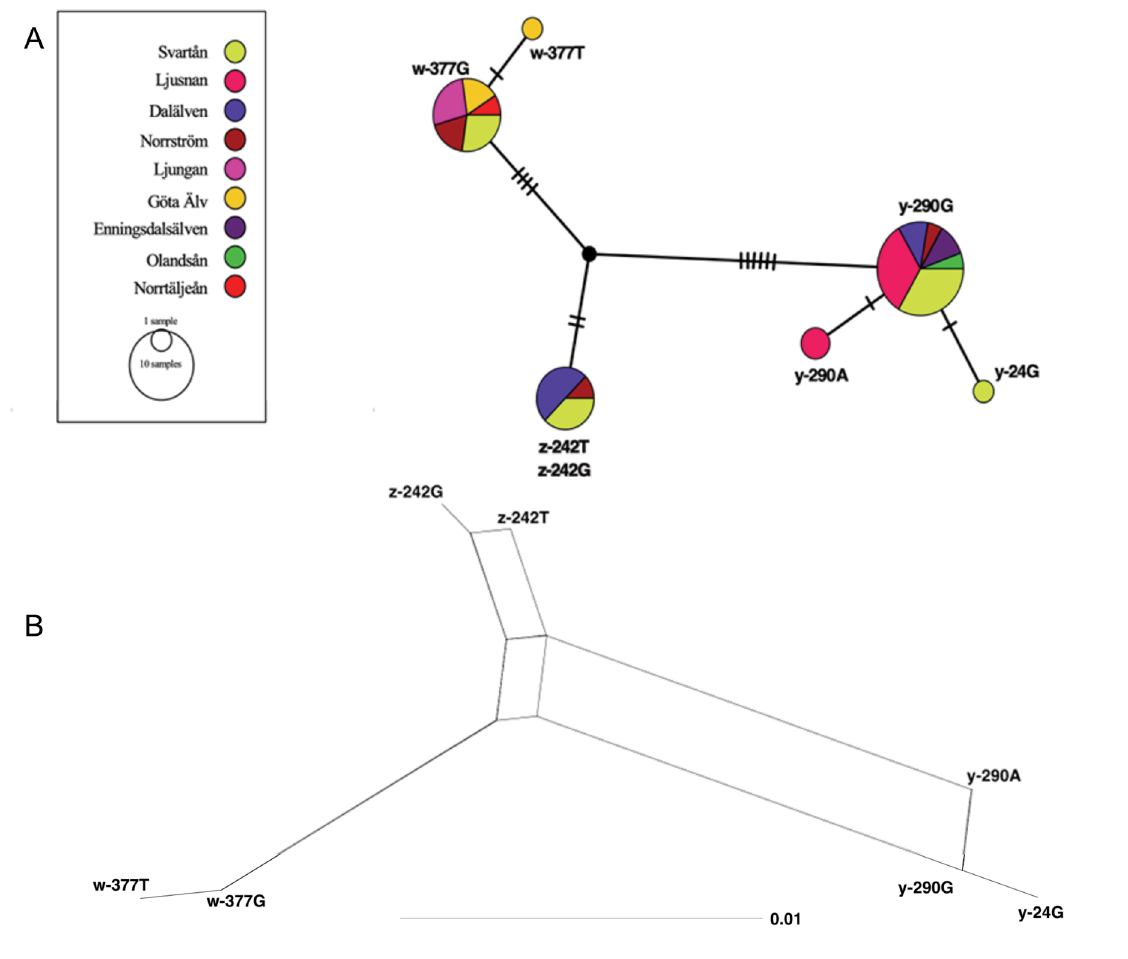
Fig. 7. Networks of i56 varieties in Swedish Spongilla lacustris (Linnaeus, 1759). Colours indicate catchment area. Seven varieties are designated; z-242T, z-242G, t-24G, y-290G, y-290A, w-377G